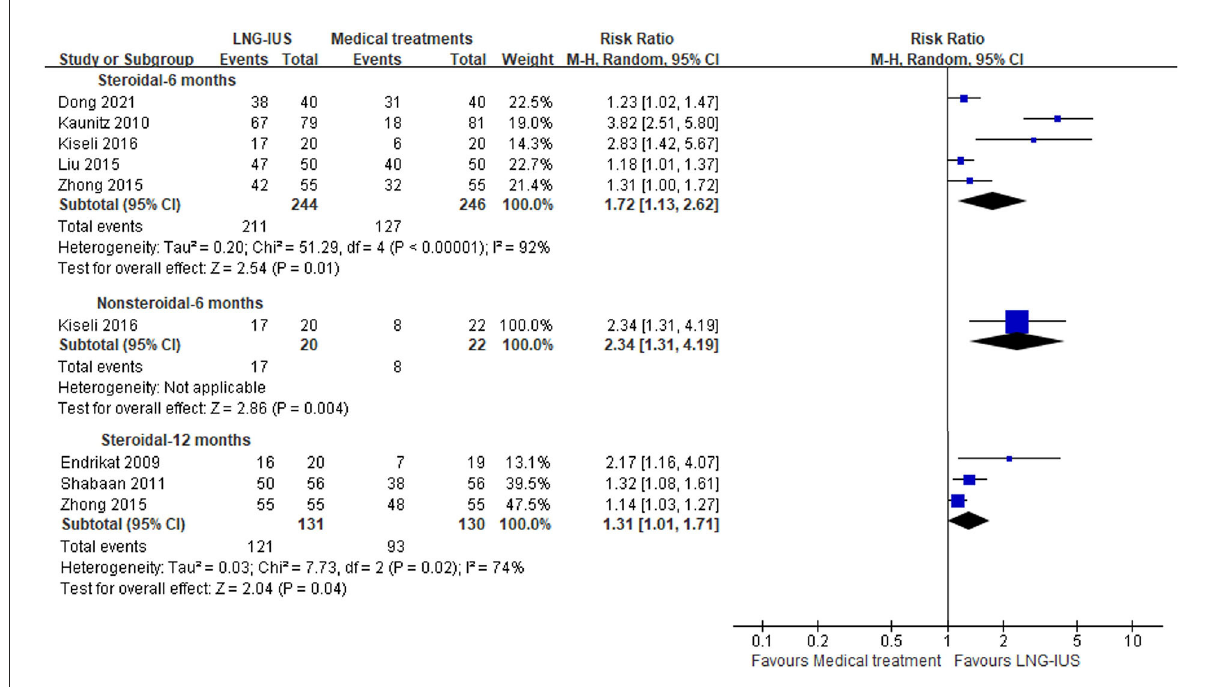
FIGURE3 Forest plots of LNG-IUS compared with medical treatment for clinical response at 6 and 12